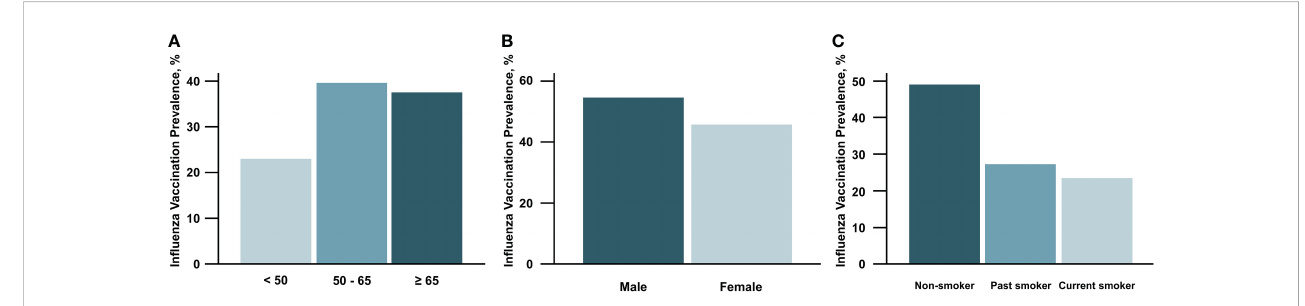
FIGURE 3 Prevalence of in fl uenza vaccination according to age (A) , sex (B) , and smoking status (C) in participants with diabetes mellitus.